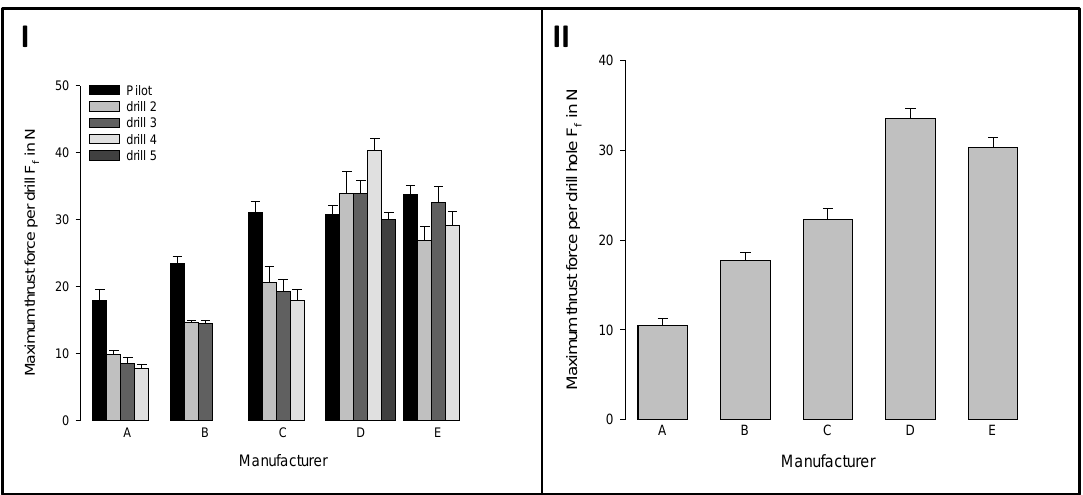
Figure 4. Exemplary signals of the thrust force F f of two subsequent drilling cycles for the same tool (Manufacturer B, Pilot drill).